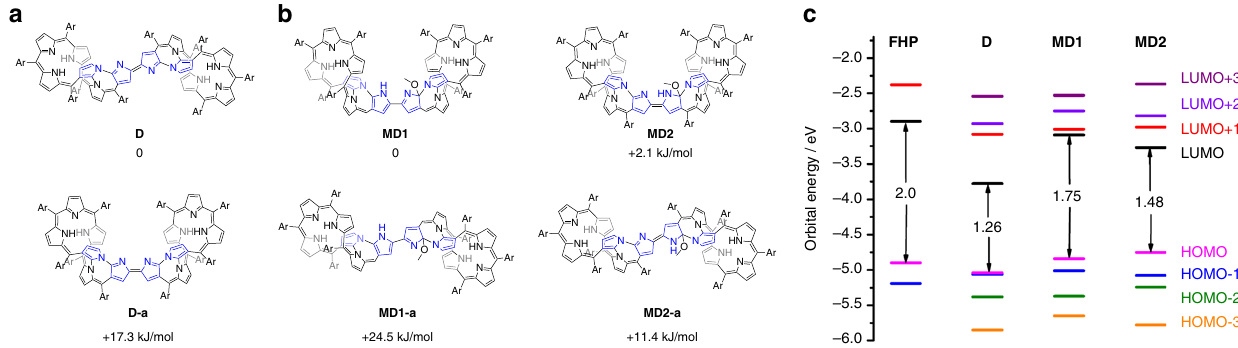
Fig. 6 DFT-calculated relative/orbital energies at the B3LYP/6-31G(d) level of theory. a Computationally derived relative energies of D - a ; and the putative cis isomer of D ; b computational relative energies of the unsymmetrical dimers MD1 , MD2 , and the possible trans isomers MD1-a and MD2-a ; c selected molecular orbital energies for FHP and dimers D , MD1 , and MD2 . Ar = C 6 F 5 . The blue-colored pyrrolic units in a and b represent confused pyrroles that are linked with adjacent pyrroles or meso-carbons through C α -C β or N-C